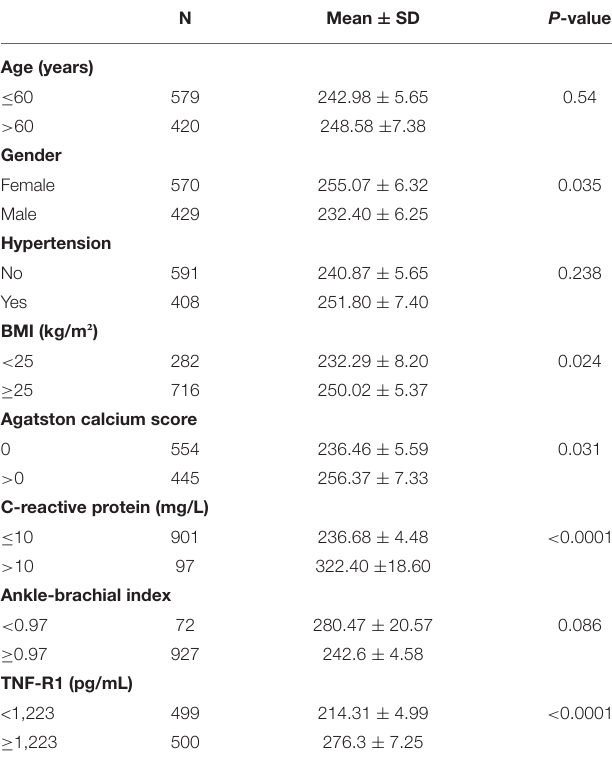
TABLE 1 | Association between serum MMP9 level and the clinicopathological